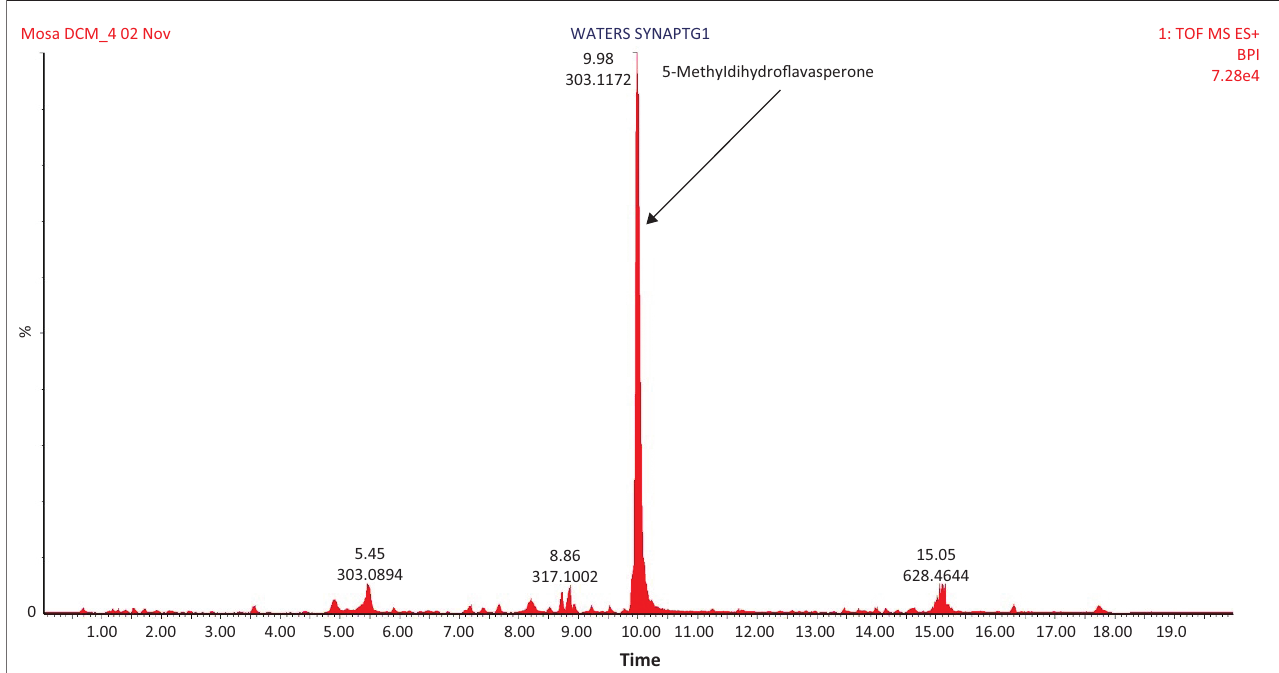
FIGURE 6: Ultra-performance liquid chromatography Time-of-Flight positive electrospray base peak intensity (UPLC TOF ESI + BPI) chromatogram of the subfraction (4/7/5) with the highest antioxidant activity.